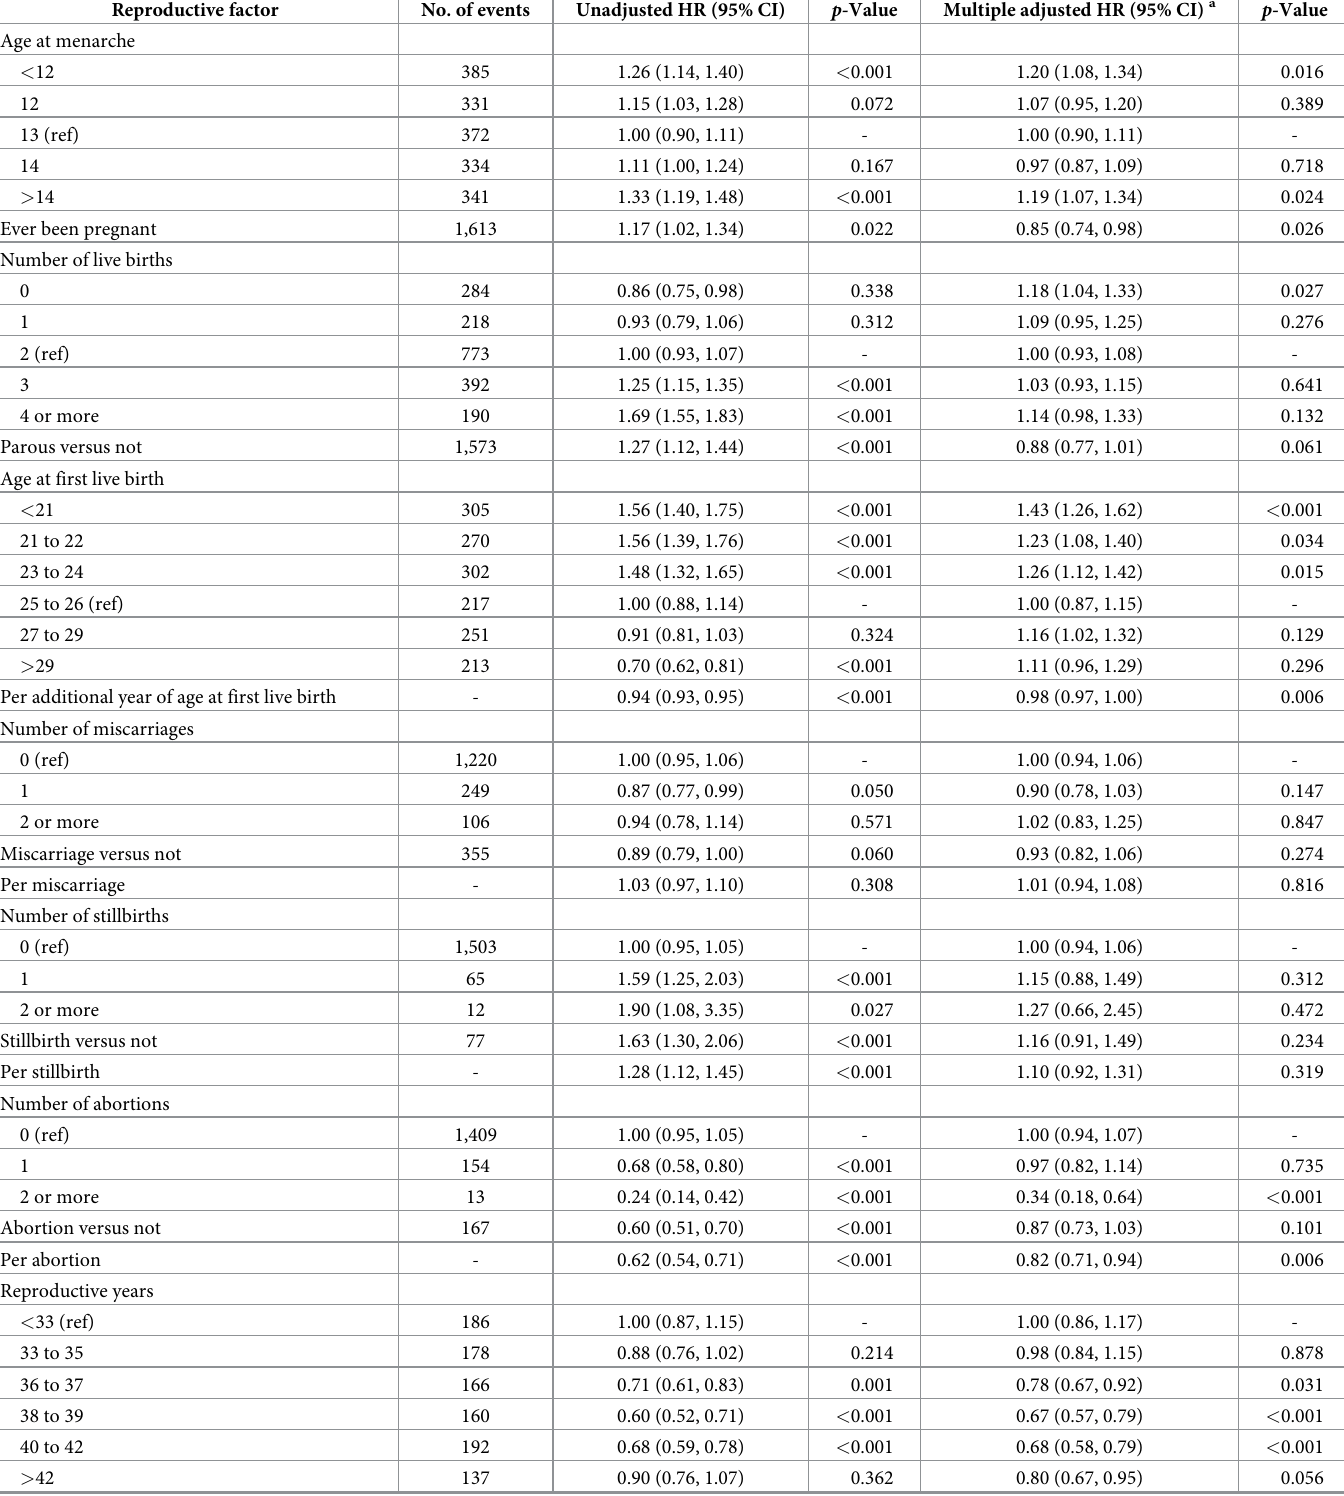
Table 3. Unadjusted and multiple adjusted HRs for the risk of dementia associated with reproductive factors in women. Reproductive